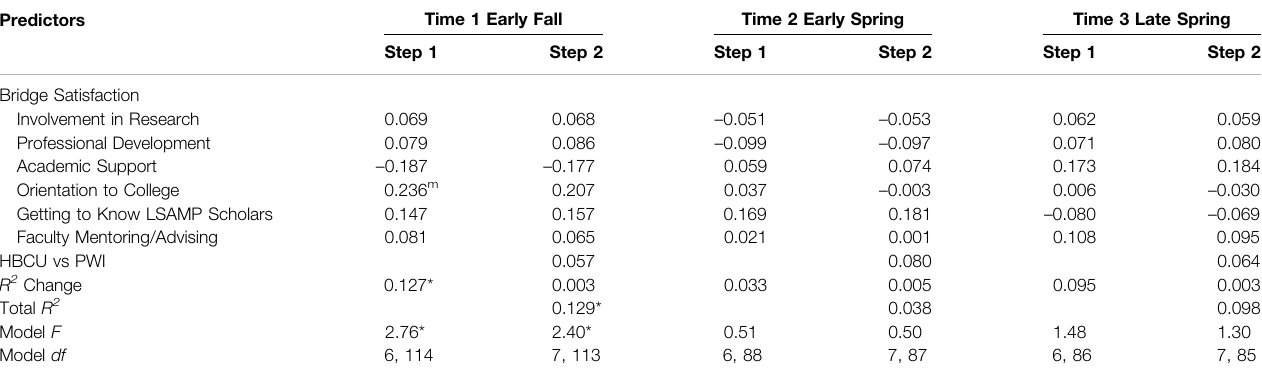
TABLE 5 | Regressions Predicting STEM Self-Ef fi cacy from Bridge